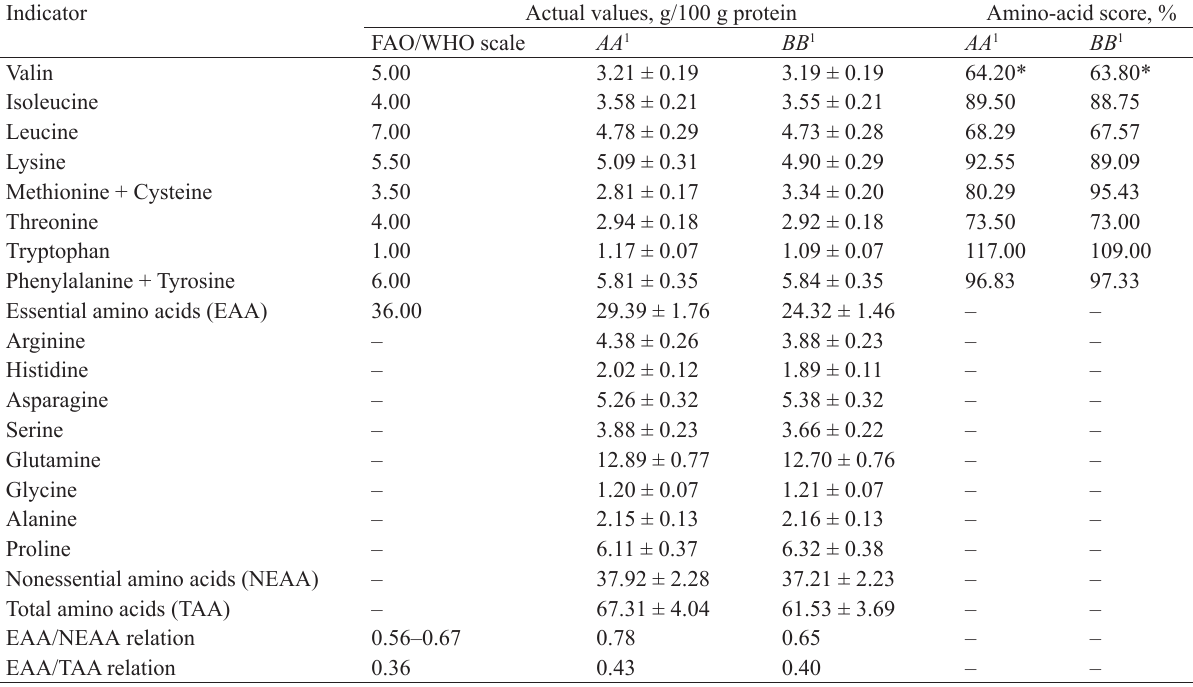
Table 3 Amino acid composition of whole milk from cows with different CSN3 genotypes